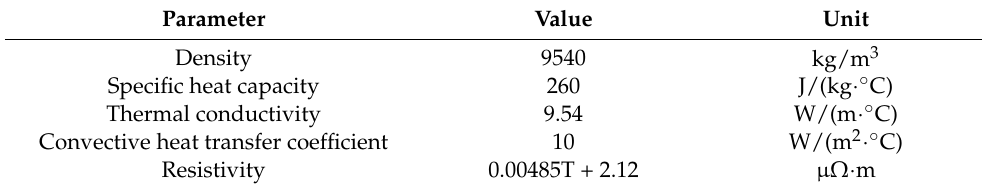
Table 1. Material parameters of the bridge area of the TaN EC element.